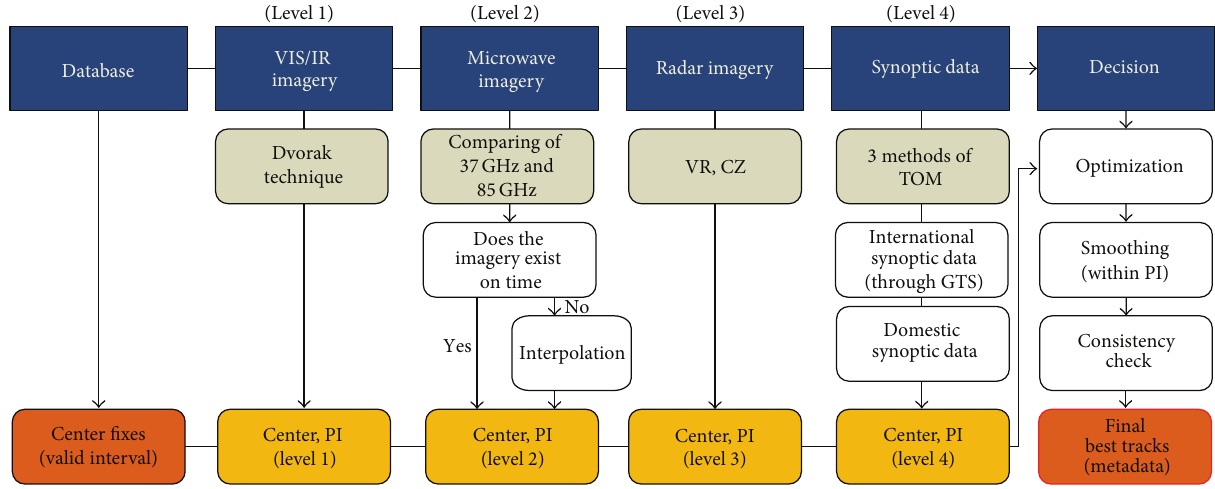
Figure 13: Flowchart of the tropical cyclone center positioning for producing the best